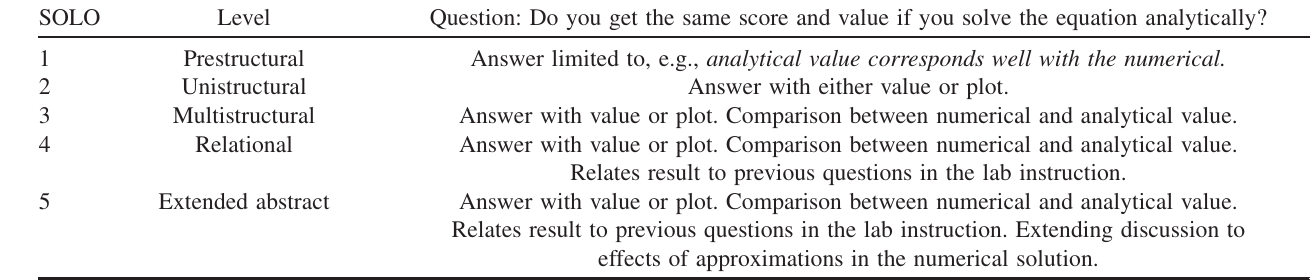
TABLE I. Example of SOLO analysis of lab score.